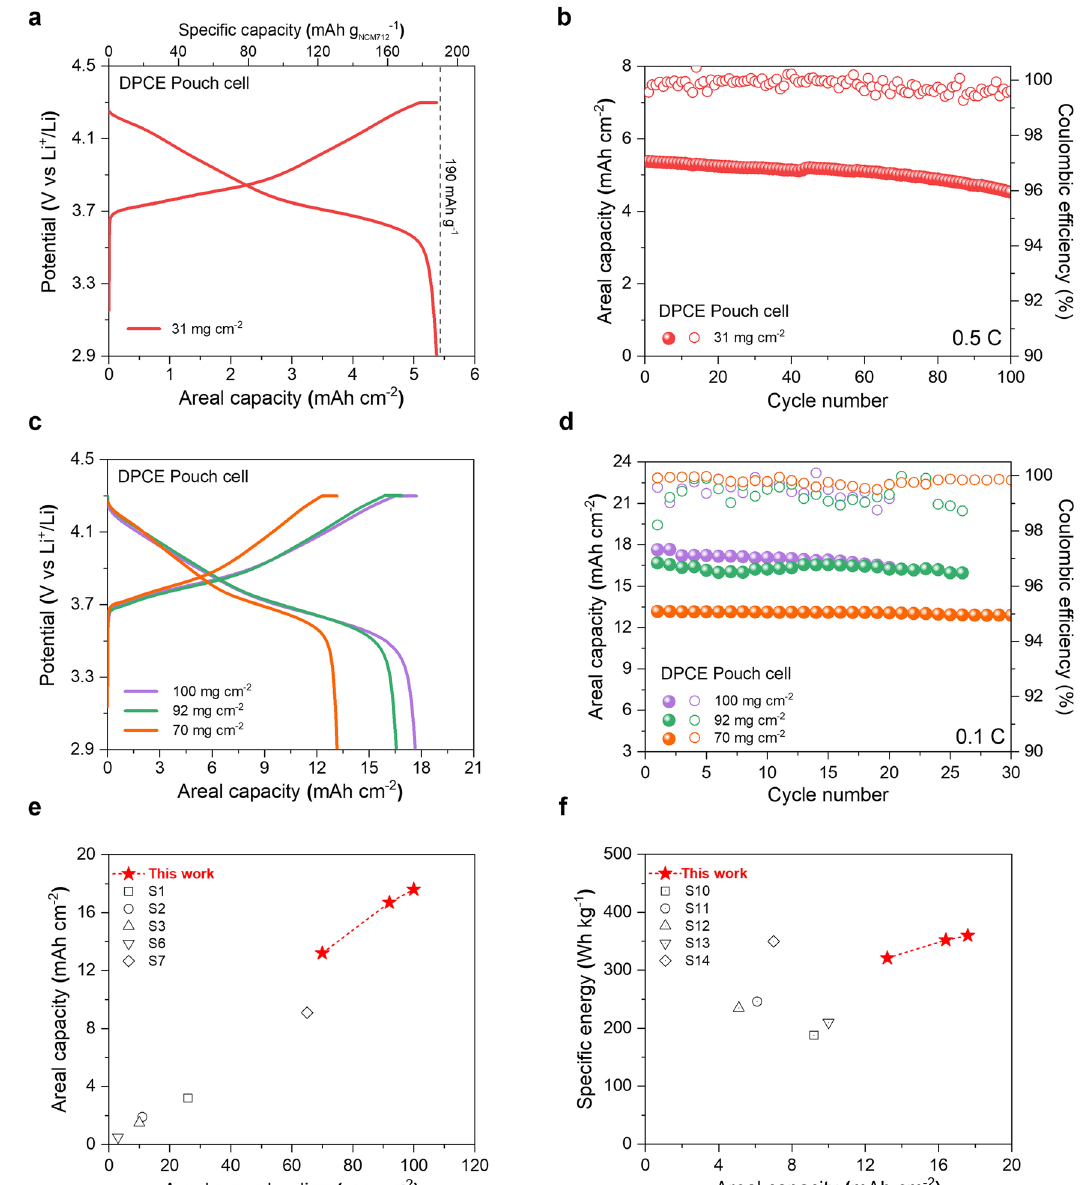
Fig. 6 | The high mass loading DPCEs (Pouch-cells). a Charge/discharge voltage pro fi le of the Li-metal DPCE pouch cell (31mgcm − 2 ) at a voltage range of 2.9 – 4.3V and charge/discharge current density of 0.1/0.1C (dashed line represents the the- oretical capacity of NCM712). b Cycling performance of the Li-metal DPCE pouch cell (31mgcm − 2 ) at a charge/discharge current density of 0.5/0.5C at a